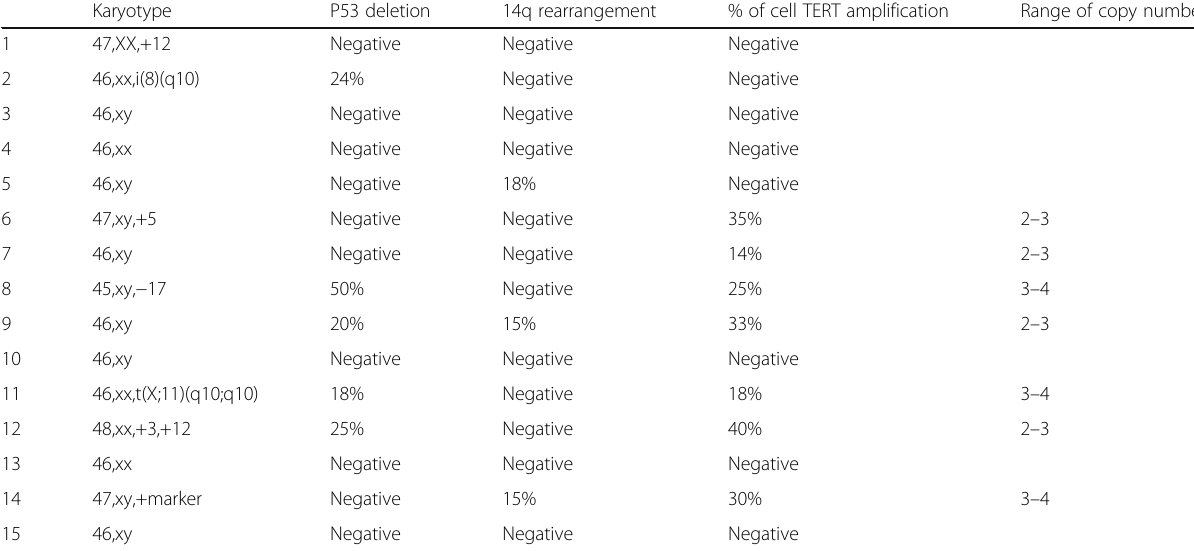
Table 4 Cytogenetics results of B-non-Hodgkin lymphoma (group II) Karyotype P53 deletion